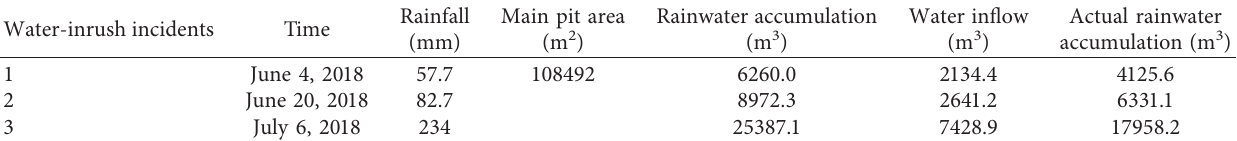
Table 3: Rainwater accumulation of each water-inrush